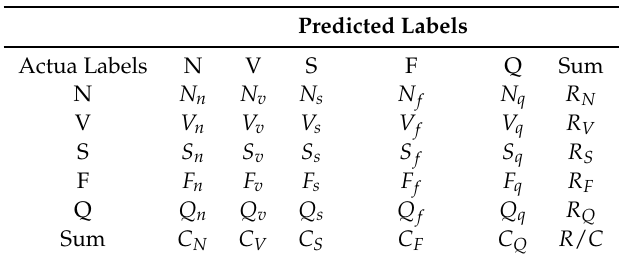
Table 5. Confusion